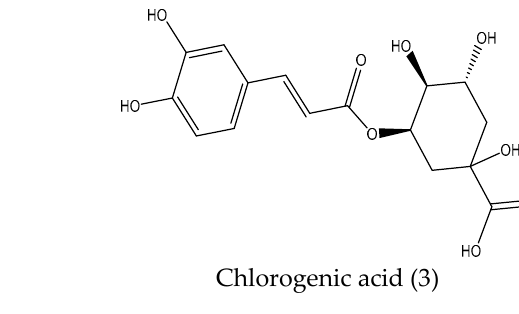
Table 1. Antibacterial activity of tetracycline, catechin, and chlorogenic acid against the tested pathogenic bacterial